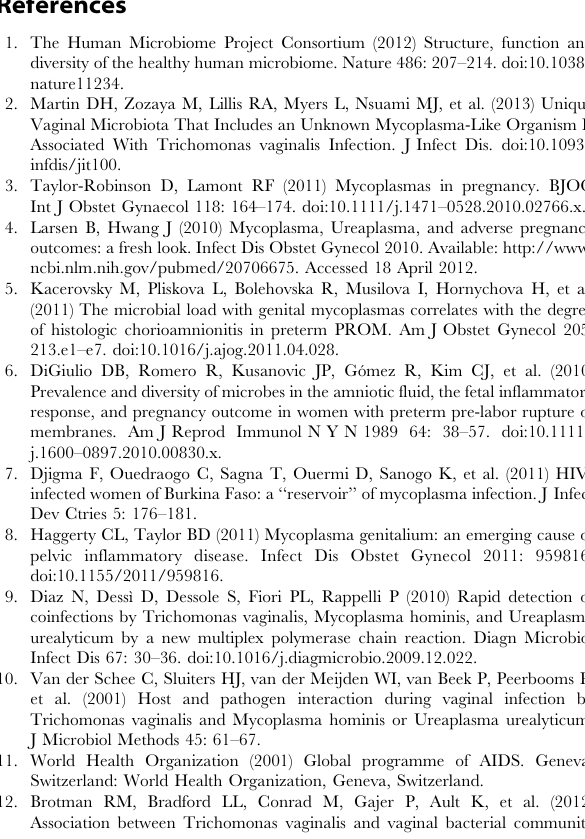
Table S1 Distribution of Clusters of Orthologous Groups (COGS). Table S2 Putative transporters in ‘‘ Ca . M. girerdii’’ strain VCU_M1. Table S3 List of primers for circularization of ‘‘ Ca . M. girerdii’’ genome. Table S4 Hominis Group orthologs. Table S5 Pneumoniae and Hemoplasma Group ortho- logs. Table S6 Spiroplasma, Phytoplasma and Outgroup